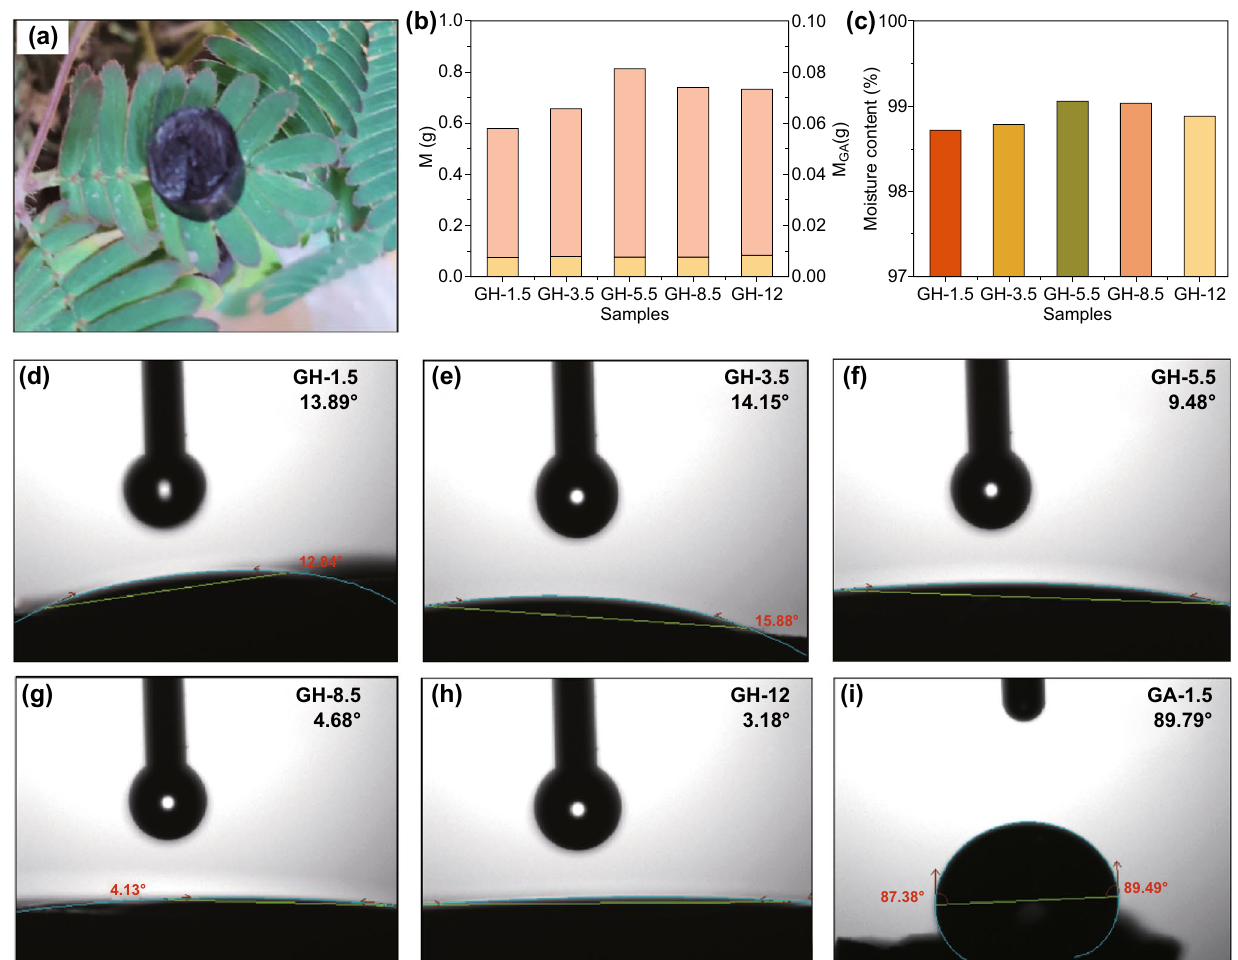
Fig. 4 a Optical image of GA, b a quality comparison of the GA and GH samples, and c the moisture content of the GH samples. Contact angle of ( d – h ) the GH samples and i